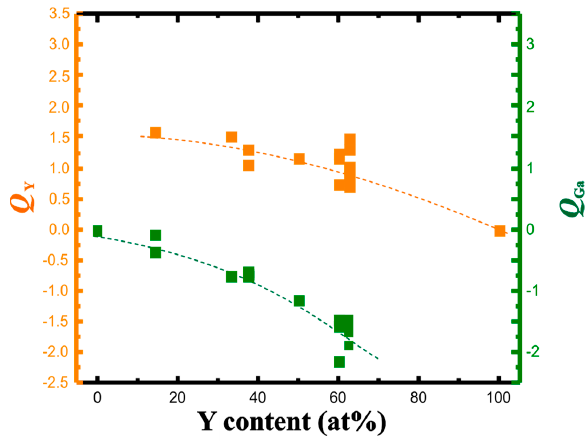
Figure 3. QTAIM charges of yttrium (orange) and gallium (green) in the Y-Ga compounds in dependence on the yttrium concentration. Dashed lines are eye-guides only.